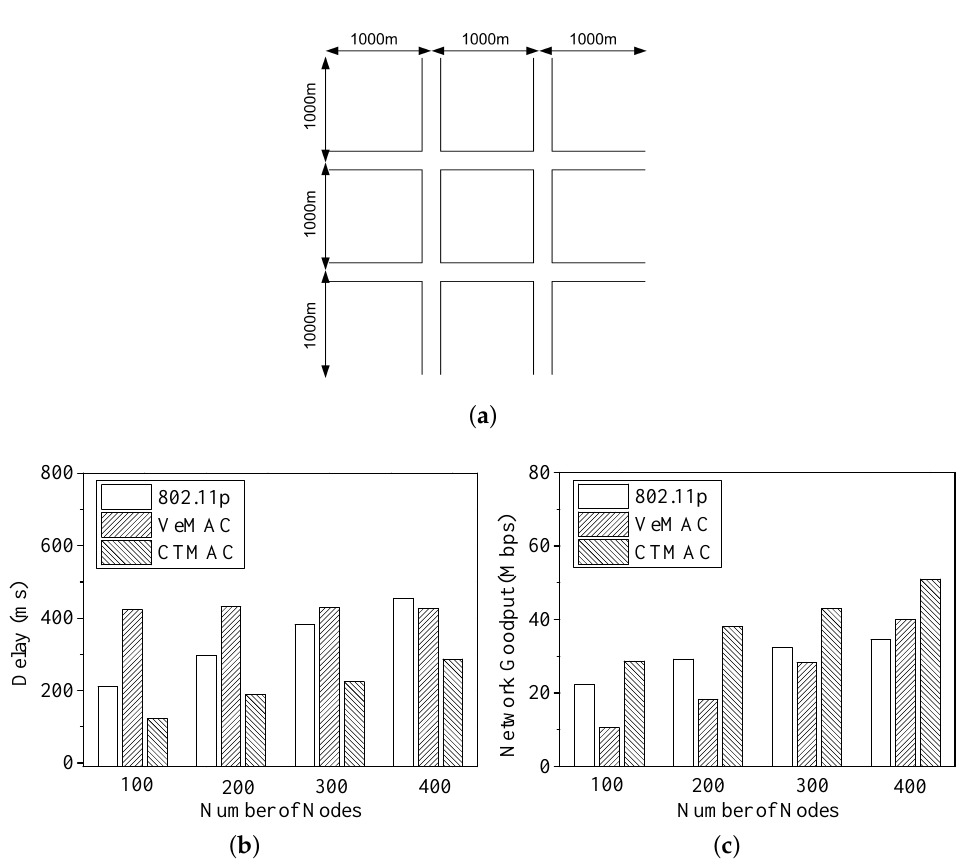
Figure 12. Urban Scenario: Delay and network goodput under different vehicle densities. ( a ) Urban Scenario: 3000 m × 3000 m; ( b ) Delay; ( c ) Network